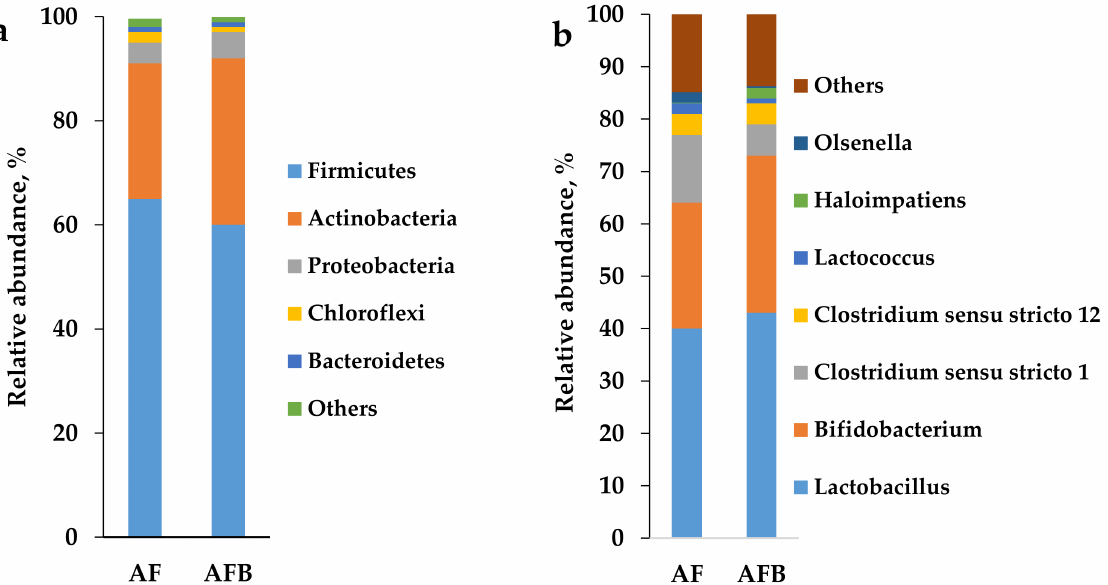
Figure 7. Compositions of microbial communities of anaerobic filter (AF) and anaerobic fluidized bed (AFB) at the phylum ( a ) and genus ( b )